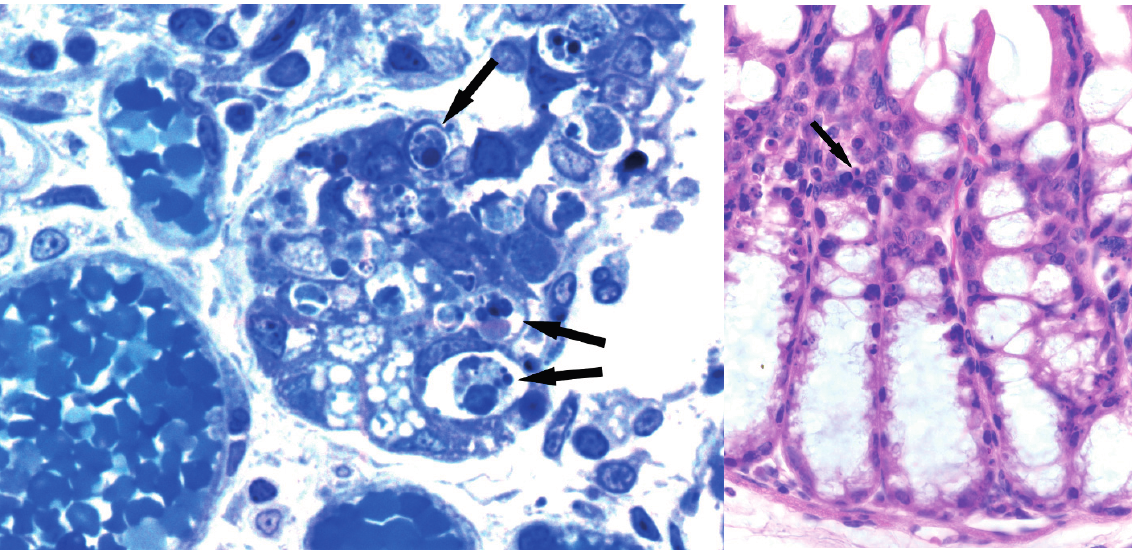
Figure 1. Effects of nigrin b on intestines. Histological sections of small ( left ) and large ( right ) intestine in mice six hours after injection with 16 mg/kg nigrin b. Lieberkühn’s crypts show atrophy due to increased apoptosis (arrows). (left) Semi-thin section stained with toluidine blue. ×1000; (right) Haematoxylin and eosin.